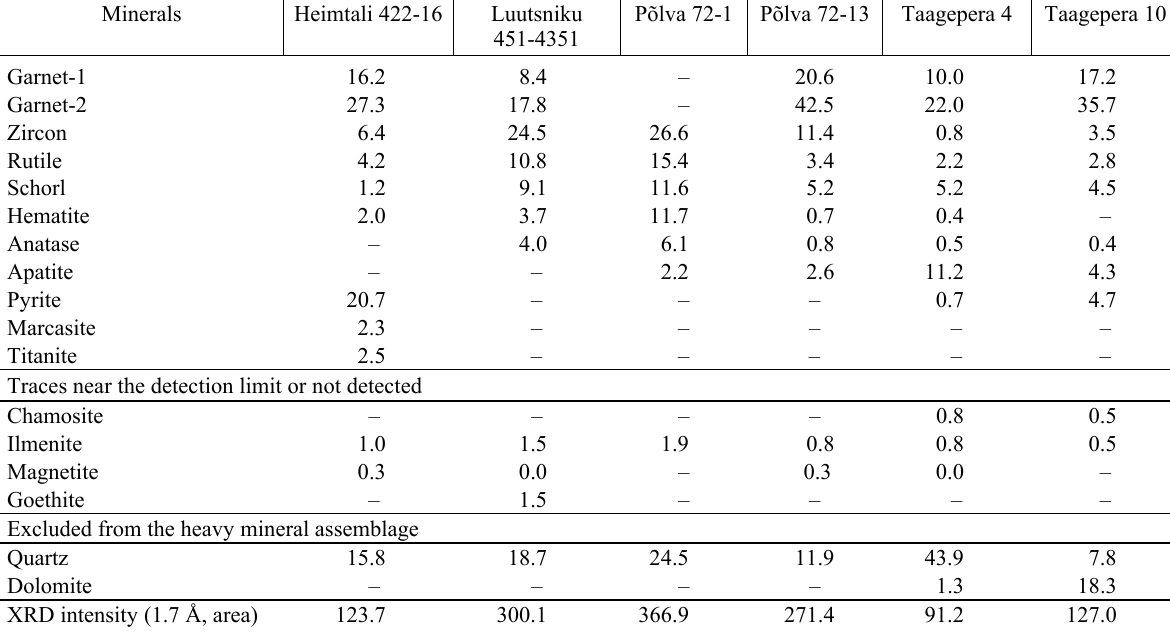
Table 7. Results of X-ray diffractometry of Devonian sandstone samples (wt% of quantified components, fraction 0.05–0.1 mm)